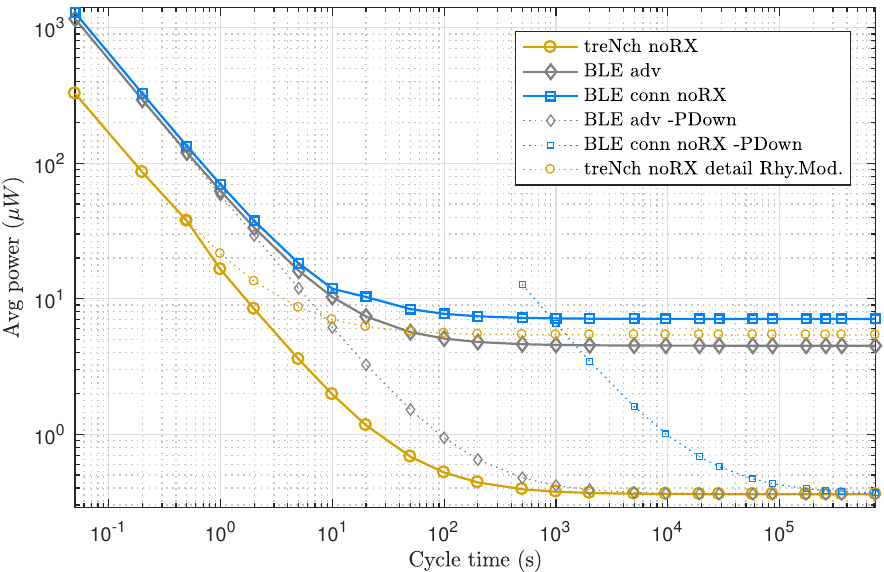
Figure 10. Use case of node with large payload needs. Average power of a complete cycle over cycle time. Maximum payload size for every WCP: treNch , 27 Bytes; BLE conn., 23 Bytes and BLE adv., 26 Bytes. Note logarithmic scale in both axes